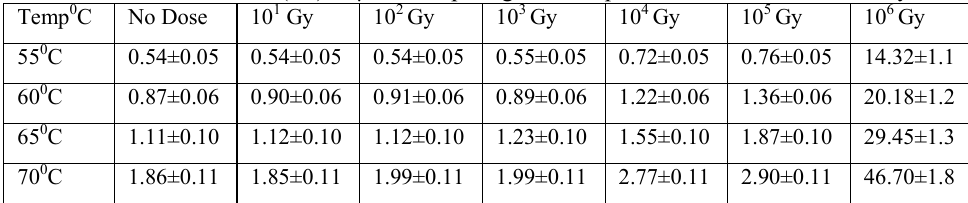
) in µm/h for post-gamma exposed PADC –American Acrylics. T